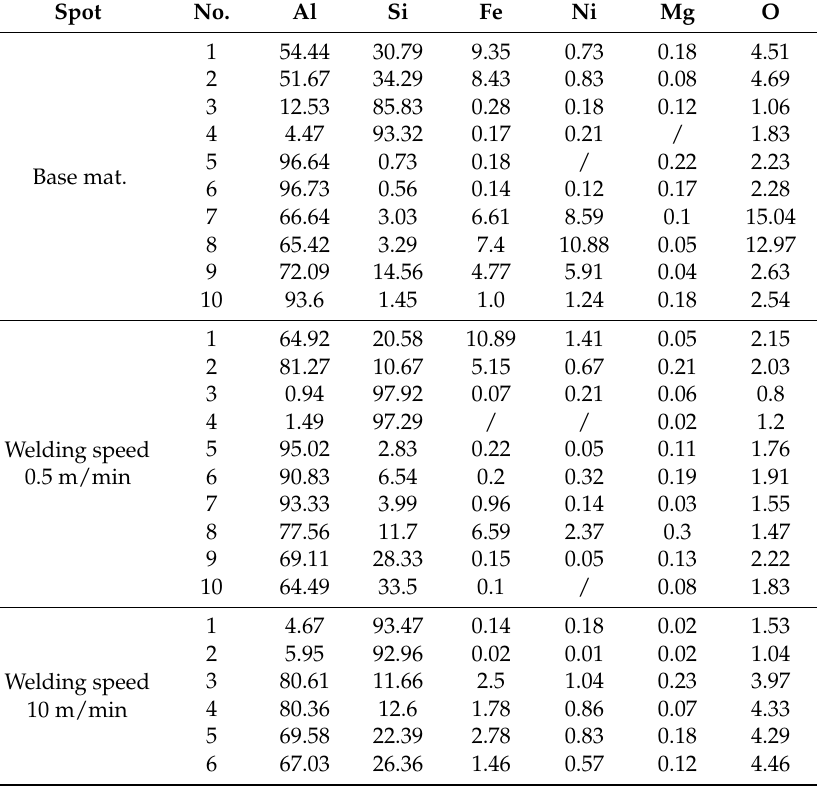
Figure 7. EDX investigation of phases in S225: Left : base material; Middle : welding speed 0.5 m/min; Right : welding speed 10 m/min. Table 4. Composition of S225 measured by EDX (at.